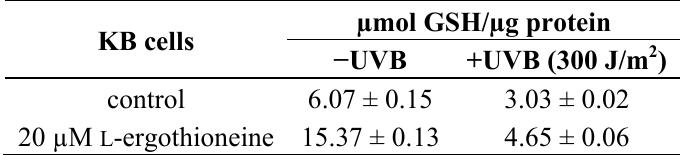
Table 2. Quantitative determination of glutathione (GSH) level in KB